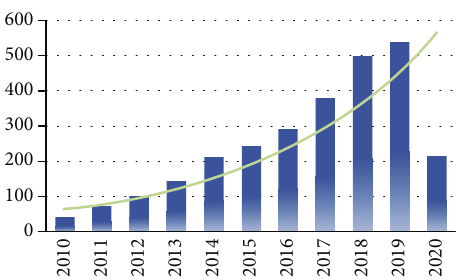
Figure 1: Numbers of publication on neuroimaging and machine learning in the last decade (from January 1, 2010, to June 1, 2020). The data was obtained by searching at the PubMed database with the items (Neuroimaging) AND (Machine